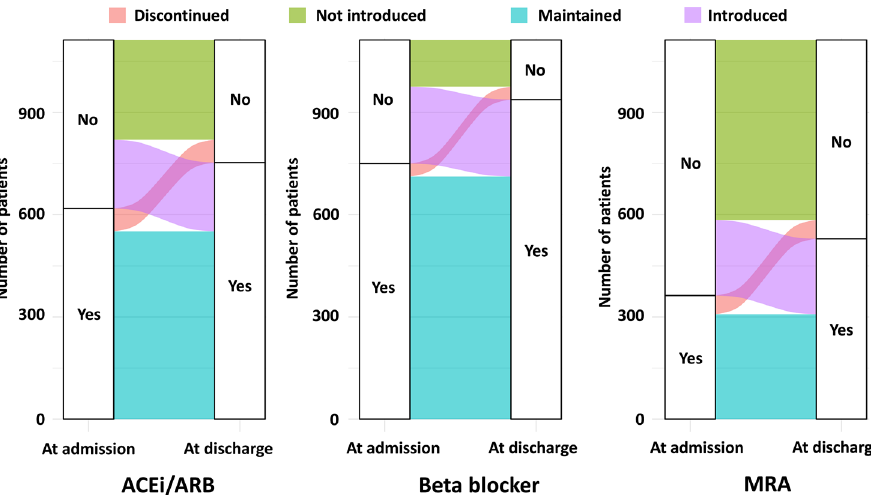
Figure 3. Modification pattern of each FMHF during hospitalization. Alluvial plot showing the changes in the prescription patterns of ACEi/ARB, beta-blocker, and MRA from admission to discharge. ACEi angiotensin-